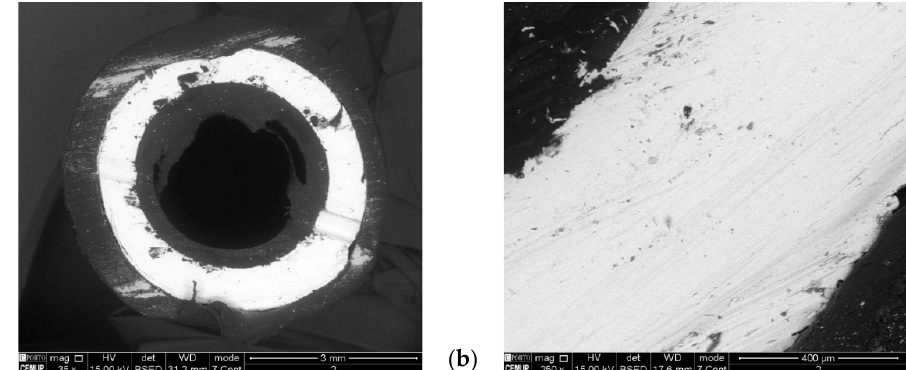
Figure 11. Microscopic images for the laminated spiral with diamond disk cut: magnification of 40 × ( a ) and 250 × ( b ).